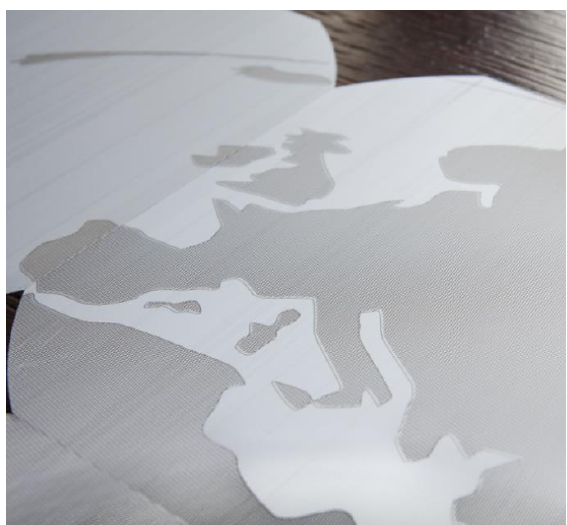
Figure 6. Large scale images of the Si wafers sub-picosecond surface hatching. Laser beam parameters: 650 fs, 343 nm, 200 kHz, 27.5 µJ; processing parameters: 7 mm/s, 15 pattern repetitions, total processing time 1.5